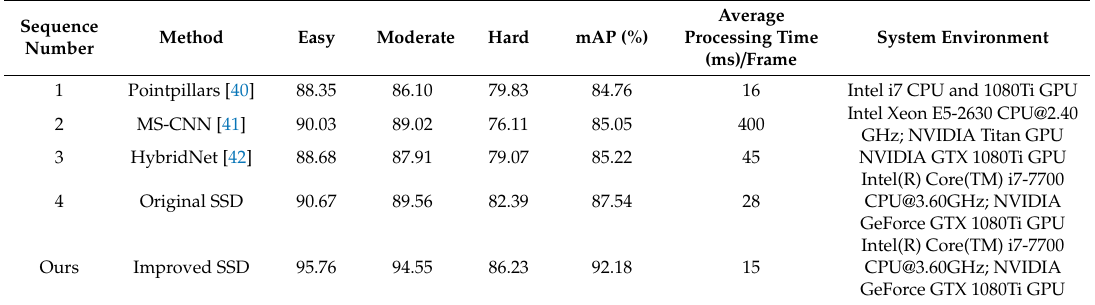
Table 3. The performance comparison statistics of algorithms on the basis of the KITTI dataset. Sequence